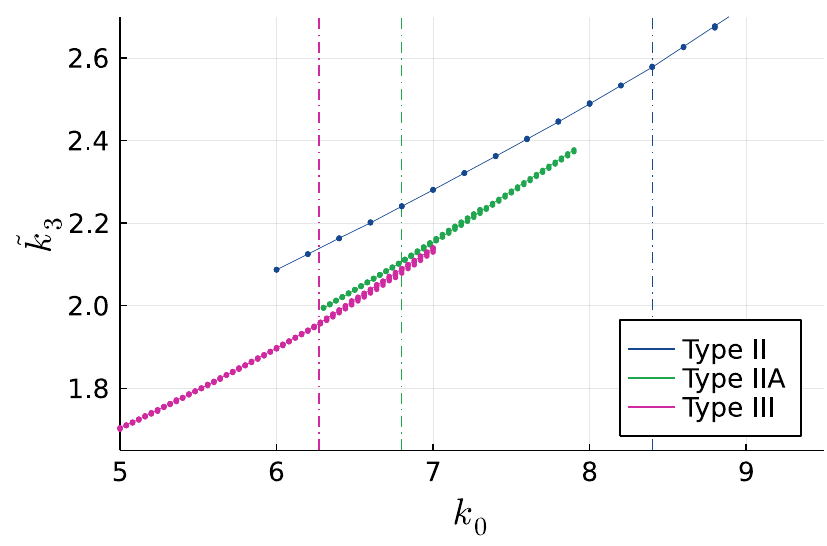
Figure 3. The critical cosmological parameter k c as a function of the bare gravitational parameter 3 k 0 for the type II (blue), IIA (green), and III (purple) CDT ensembles with T = 3 time slices and target volume ˜ N 31 = 10000 . For the spatial genus, we used the values g = 0 , 1 , 2 , 15 , 30 . The thin lines are interpolations between the data points. The results are identical within measurement error (error bars are on the order of the dot size and therefore not shown) for different genera, making all the curves for a given ensemble overlap. The vertical dash-dotted lines indicate the approximate location of the phase